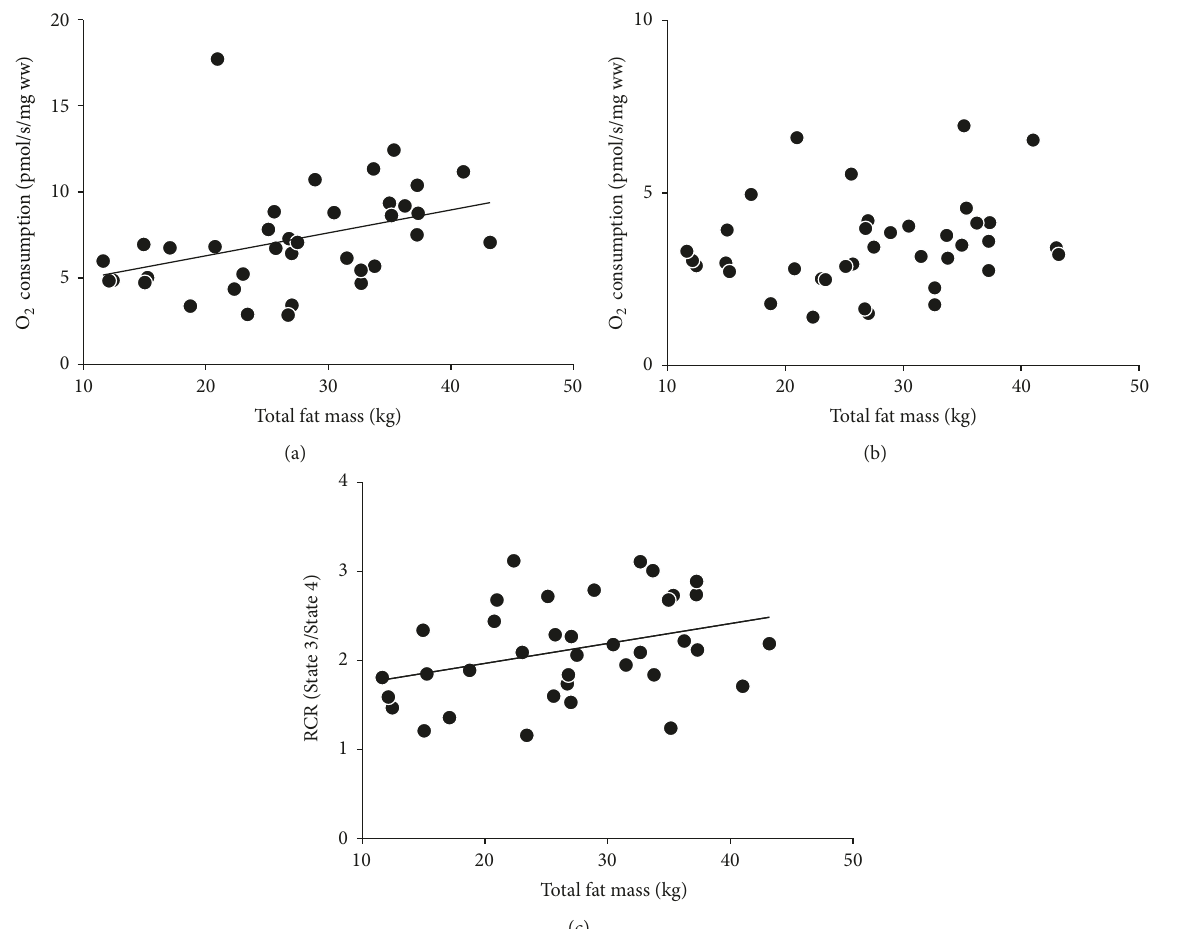
Figure 2: State 3 respiration was positively associated with total fat mass ( 𝑟 = 0.379 , 𝑝 = 0.021 ) (a). State 4 respiration was not significantly associated with total fat mass ( 𝑟 = 0.216 , 𝑝 = 0.193 ) (b). RCR was positively associated with total fat mass ( 𝑟 = 0.348 , 𝑝 = 0.035 ) (c).